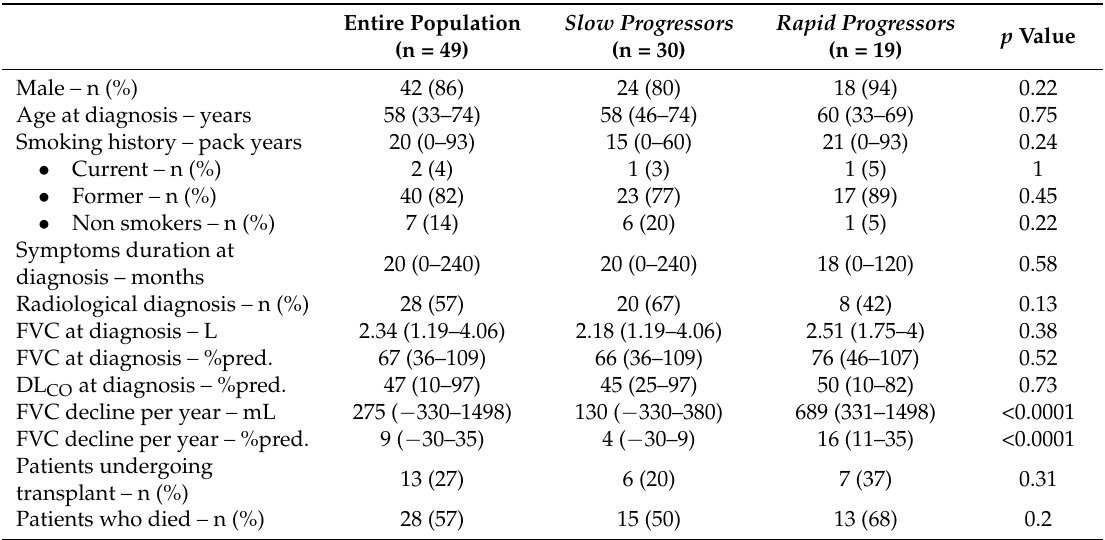
Table 1. Demographics and clinical characteristics of the entire population (n = 49), including 30 slow and 19 rapid